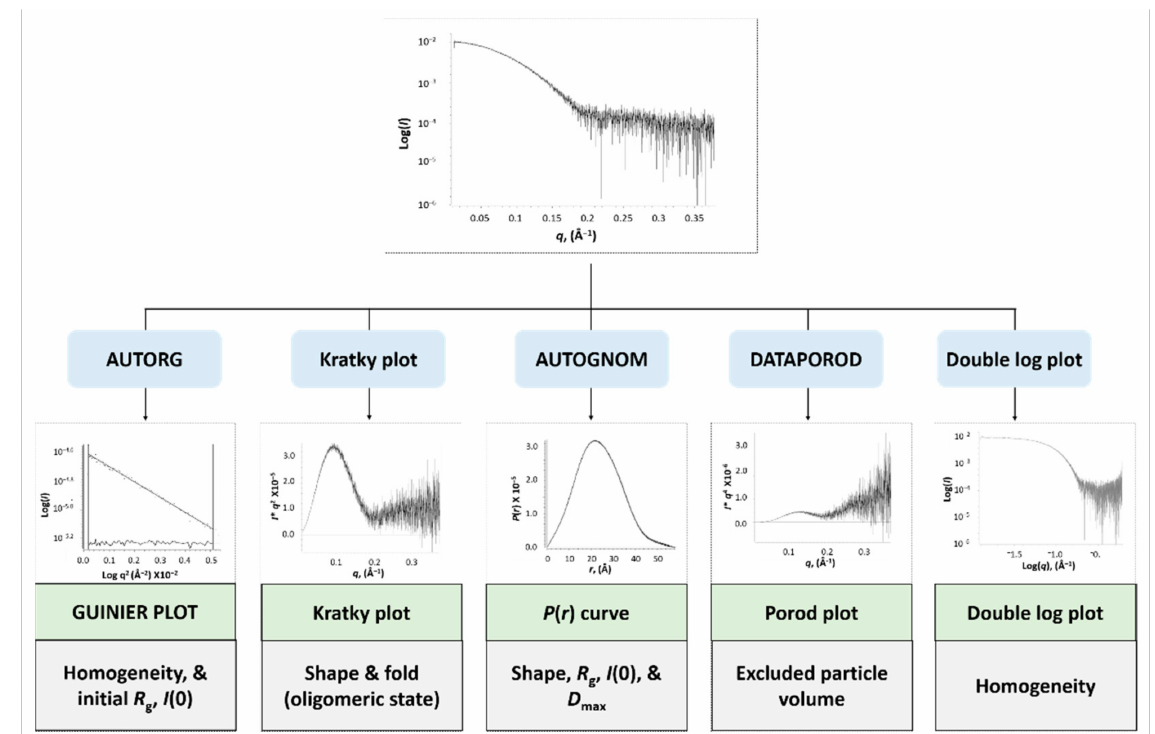
Scheme 3. Schematic of the analysis of SAXS